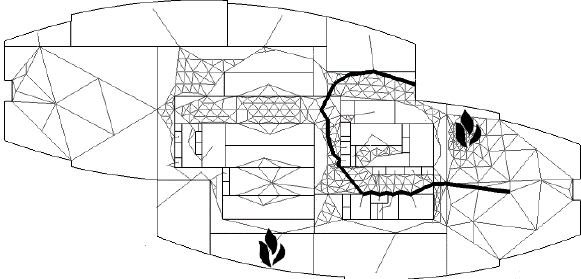
Figure 5. The safest path for two hazard epicentres ( τ = 1.720). In the last example, three typical floors of the aforementioned building are used. There are two staircases in the building which allow for vertical navigation. One hazard epicentre is located on the ground floor. The shortest and safest paths are shown in Figure 6a and Figure 6b, respectively. The length of the shortest path is 63.6 m, while the latter one is 92.7 m long.